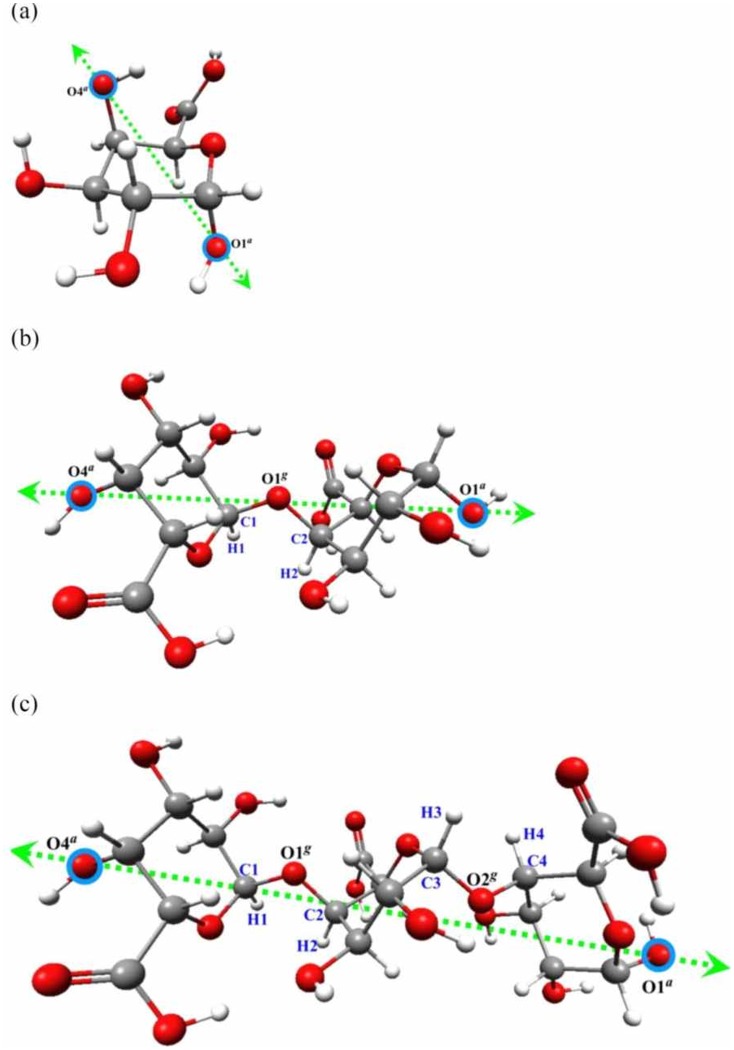
The scheme of stretching forces.The scheme of external stretching force actions on O1a and O4a oxygen atoms in α-D-galacturonic acid (a) monomer, (b) dimer, (c) trimer. Og indicates the oxygen atom involved in the glycosidic bond. The characteristic dihedral angles are defined as: φ1 = H1C1O1gC2, ψ1 = C1O1gC2H2 and φ2 = H3C3O2gC4, ψ2 = C3O2gC4H4).